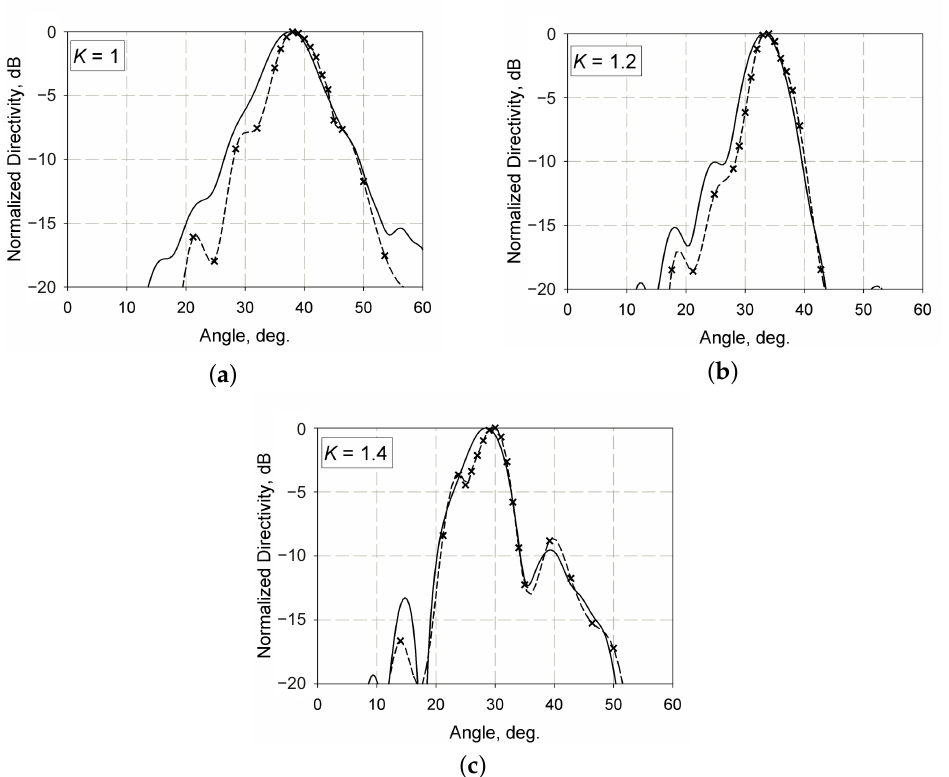
Figure 11. Comparison of the measured radiation patterns (dashed lines) and the simulated ones (solid lines) corresponding to different tunability values: K = 1—( a ); K = 1.2—( b ); K = 1.4—( c